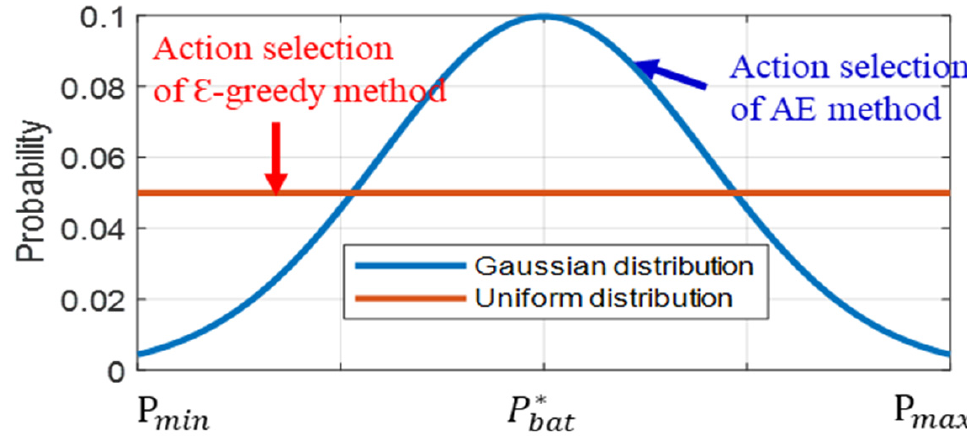
Figure 2. Probability density function of the action selection. After the actions of BESSs are selected, the environment interacts with the actions and generates the immediate rewards. The environment is the IEEE 13 Node Test Feeder in the OpenDSS [27]. The implementation of the RL is demonstrated in Figure